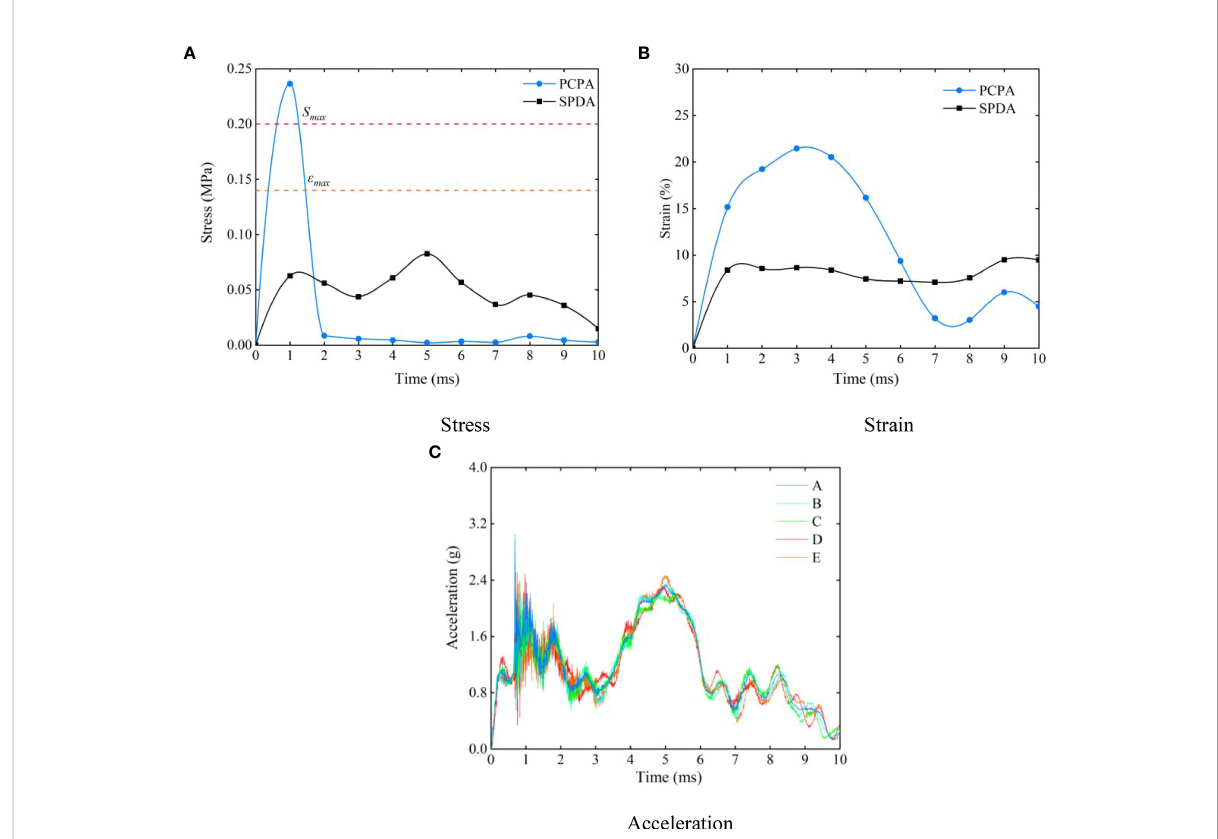
FIGURE 12 Response curves of various tissues and organs under different collision position (A) stress; (B) strain; (C)